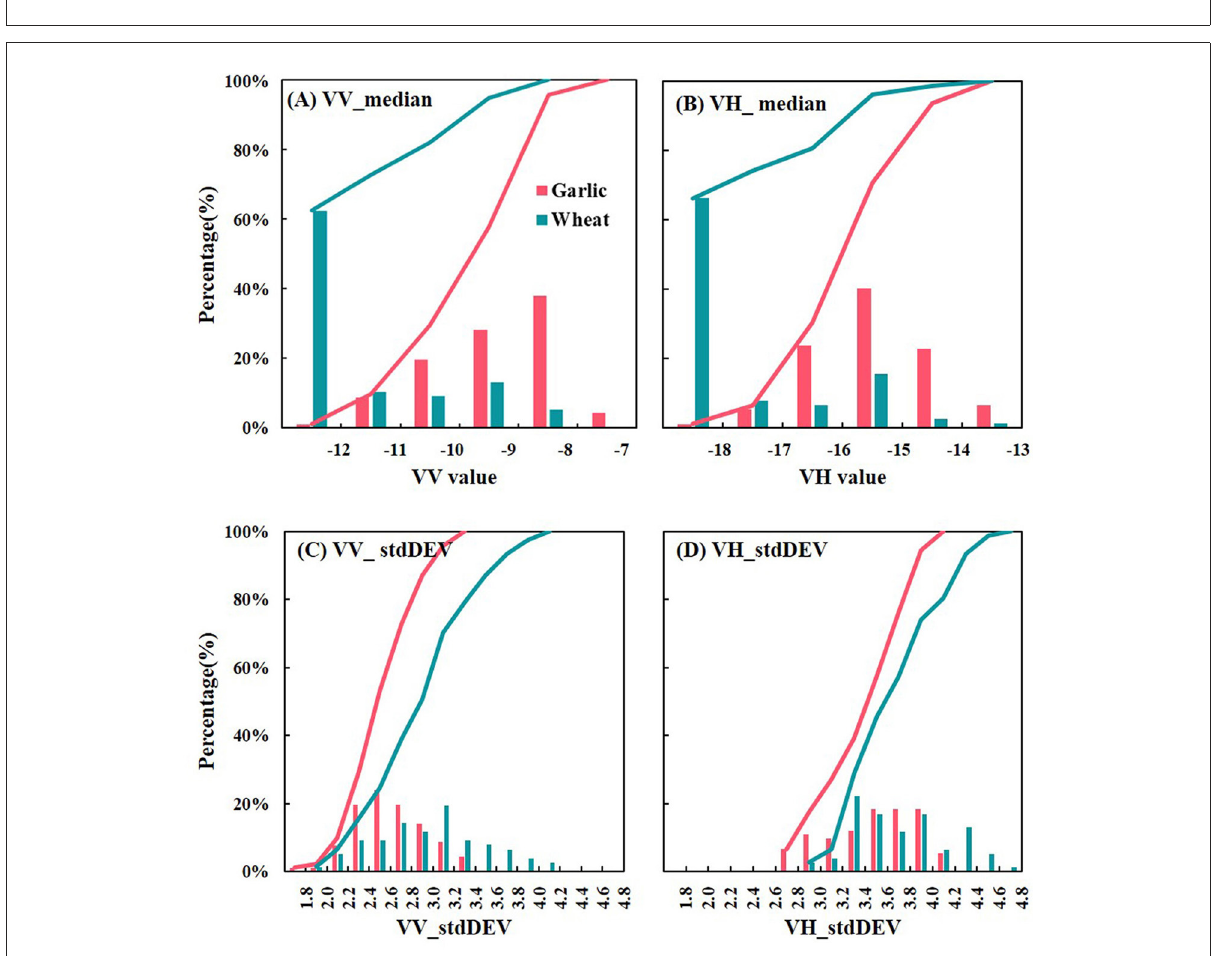
FIGURE11 Signature analysis of garlic and winter wheat at (A) VV_median, (B) VH_median, (C) VV_stdDEV, and (D) VH_stdDEV using the histogram statistics